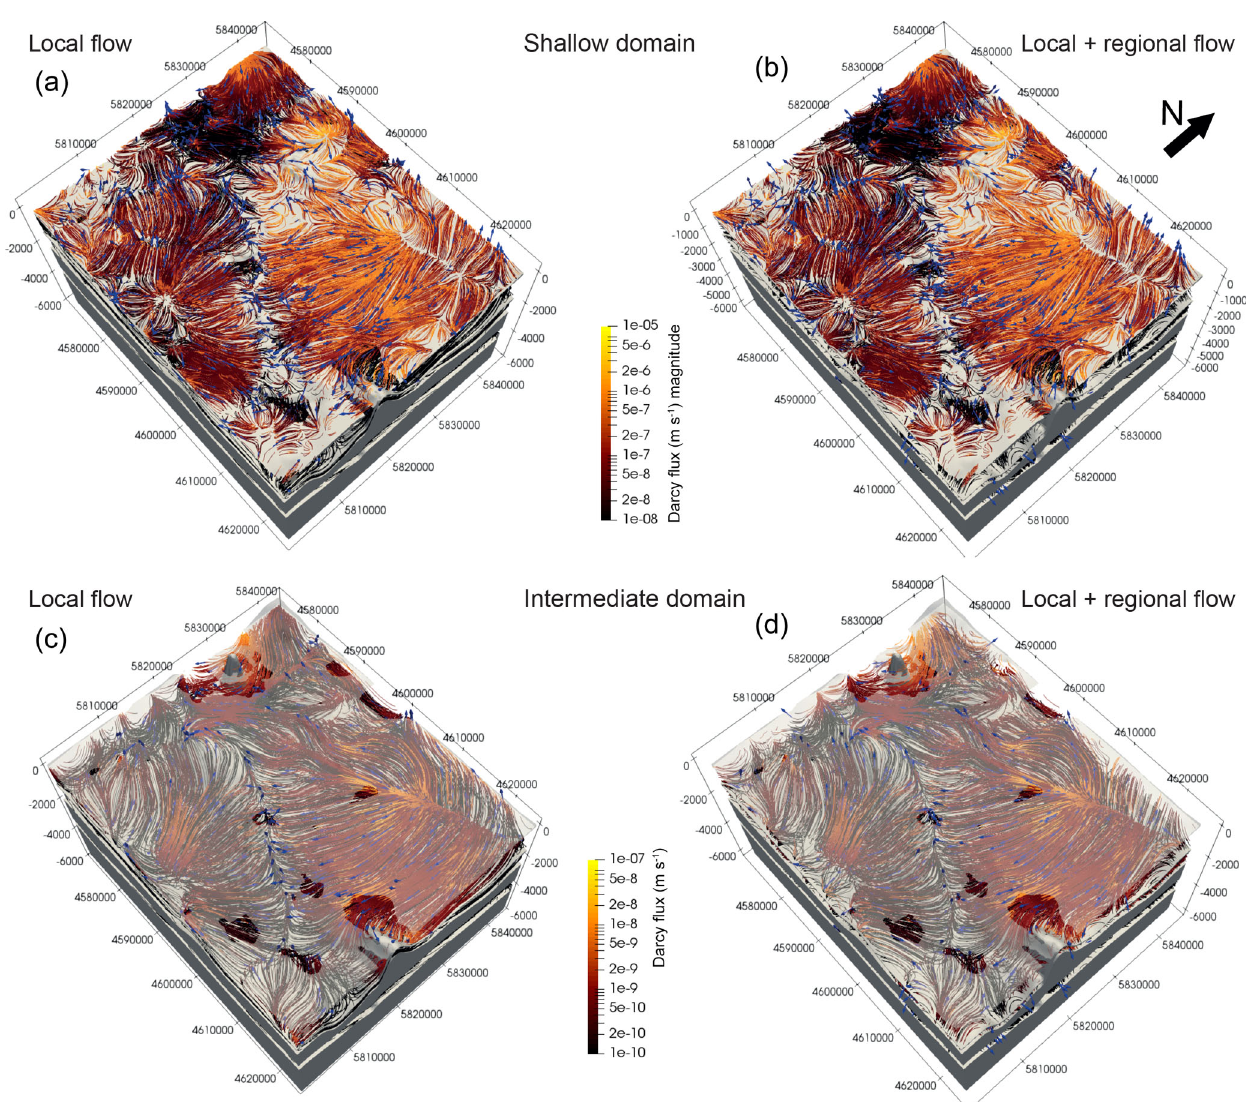
Figure 2. 3-D view of the flow dynamics at different depth levels. (a, b) Shallow domain (above Rupelian), (c, d) intermediate domain (below Rupelian, above Middle Muschelkalk). Coloured flow lines represent preferential flow directions and magnitude of Darcy velocity. Blue arrows represent flow directions. Calculated with Paraview’s stream tracer filter (Squillacote et al., 2007); Gray layers from top to bottom: Rupelian, Middle Muschelkalk, Zechstein, Basement. Coordinates [m] in Gauß-Krüger DHDN Zone